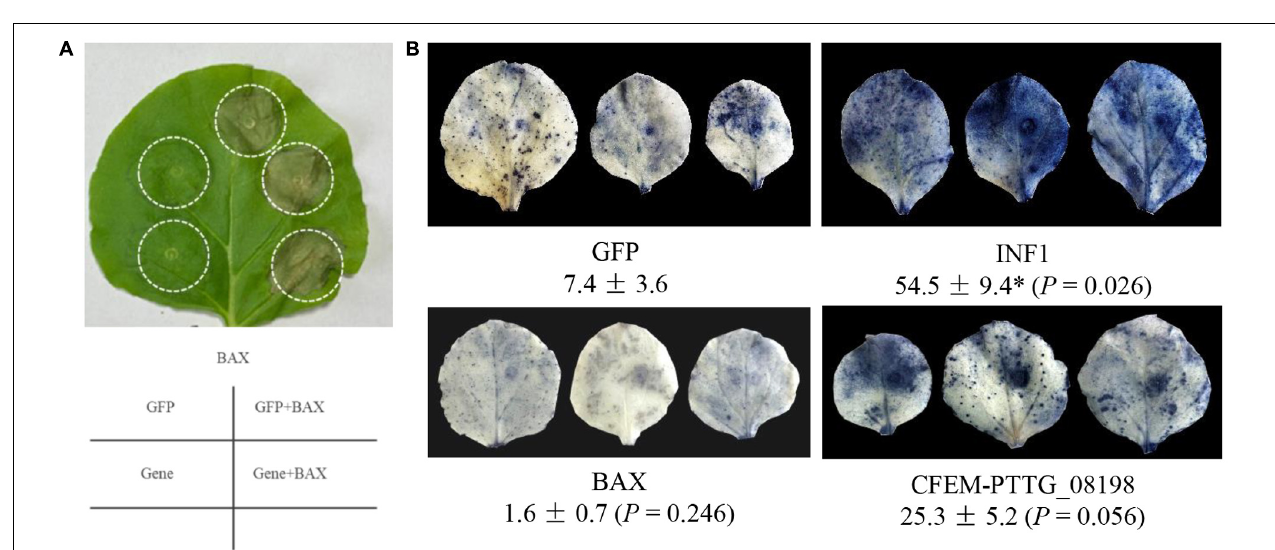
FIGURE 7 | Functional characterization of leaf rust effector candidates with conserved motifs of Y/F/WxC and CFEM. (A) Sixteen effector candidates with conserved motifs (9 Y/F/WxC and 7 CFEM) were transiently expressed in Nicotiana benthamiana using Agrobacterium infiltration. An Agrobacterium transformant carrying 35S:BAX was infiltrated 48 h after the initial infiltration of 35S:GFP (negative control) and 35S:Effector . None of the 16 tested effector candidates showed suppression of cell death triggered by the expression of BAX gene in tobacco leaves. Phenotype of BAX-induced cell death in tobacco leaves pre-expressing a CFEM effector candidate PTTG_08198 was observed 24 h earlier than those expressing 35S:GFP and other effector candidates. (B) Tobacco leaves were fully infiltrated with Agrobacterium transformant carrying 35S:GFP (negative control), 35S:INF1 (positive control), 35S:BAX , or 35S:CFEM-PTTG_08198 , respectively. Infiltrated leaves were collected at 24 hpi and subjected to NBT staining to visualize the accumulation of ROS. The percentage of the superoxide anion (O 2 − ) accumulation area in the infiltrated leaf was calculated using the ASSESS software v2.0. The asterisk (* P < 0.05) indicates the significance of the differences between the GFP control and effector by Dunnett’s